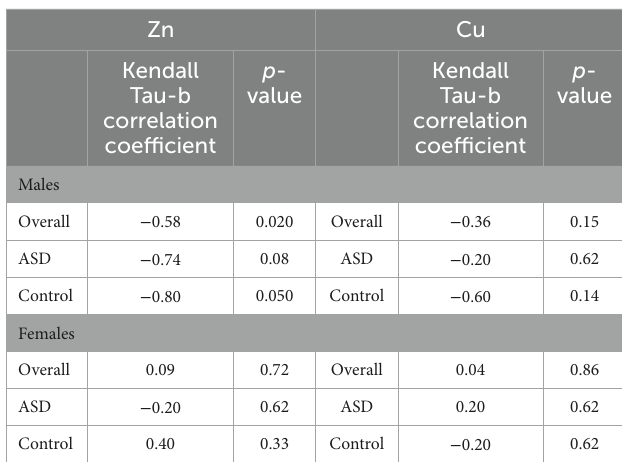
TABLE 3 Correlation between total Cu and Zn concentrations and